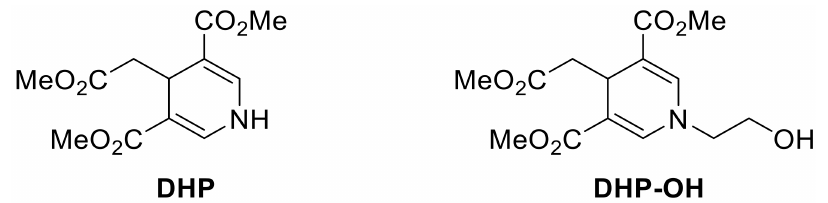
Figure 1. The structure of designed fluorescent